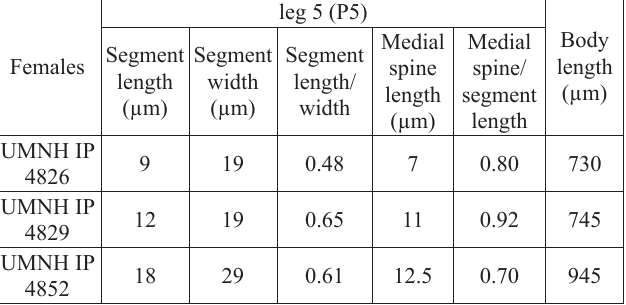
Table 2. Morphometric characters of leg 5 in the adult female of Apocy- clops californicus sp. nov. (absolute values are rounded). leg 5 (P5) Females